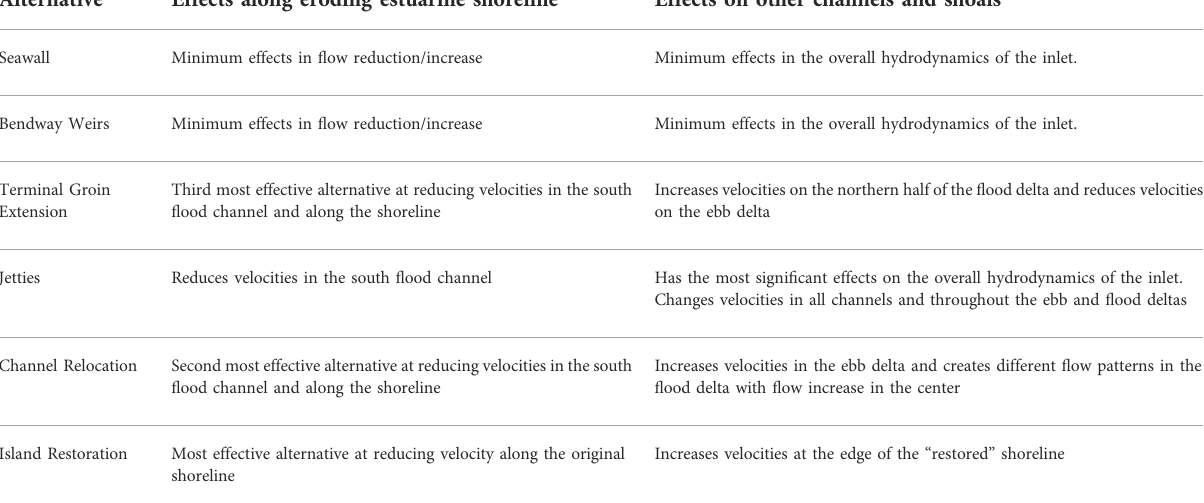
TABLE 5 Coastal protection alternatives with their effects on velocities within the inlet